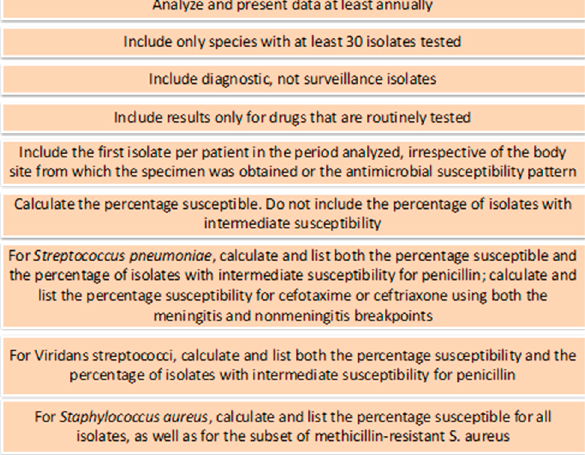
Figure 1. Steps for a cumulative antibiogram (adapted from Hindler JF, Stelling J. Analysis and presentation of cumulative antibiograms: a new consensus guideline from the Clinical and Laboratory Standards Institute. Clin Infect Dis. 2007 Mar 15;44(6):867–73).